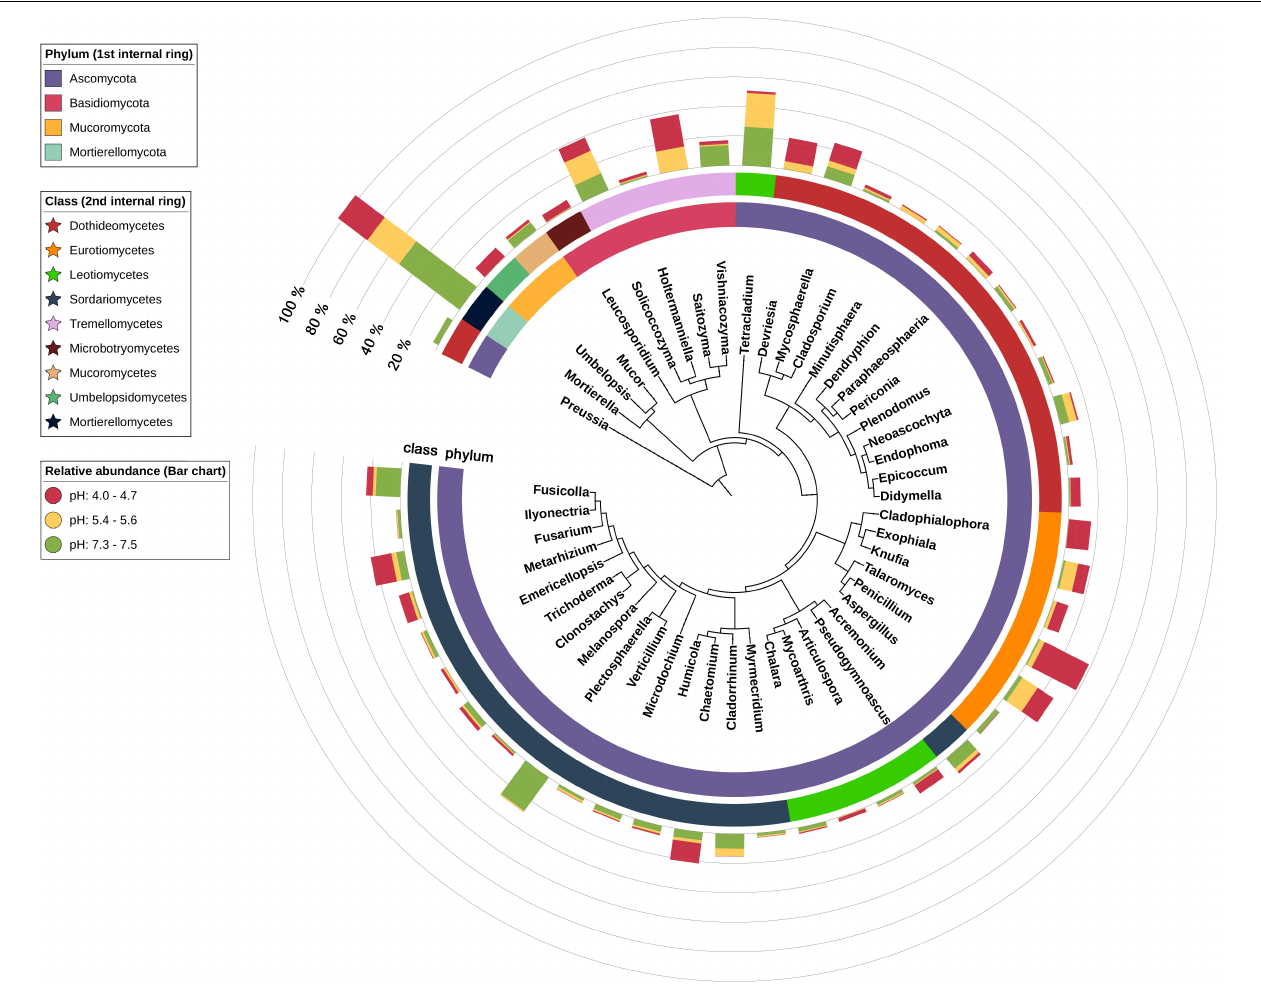
FIGURE 4 | Phylogenetic tree of the 50 most abundant fungi. First internal ring’s coloring indicates phylum, second – class and bar chart colors indicate pH group of each